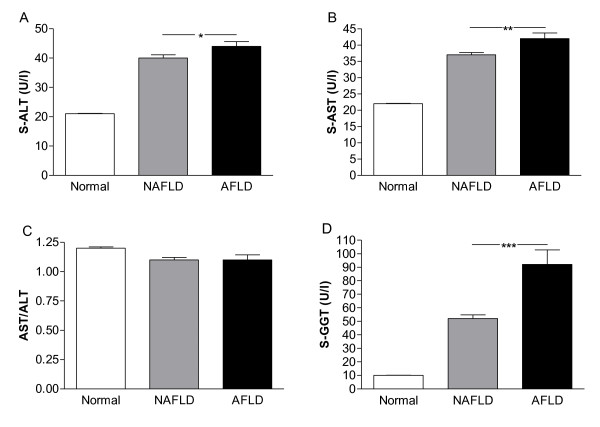
(A) S-ALT concentrations, (B) S-AST concentrations, (C) AST/ALT-ratio, and (D) S-γGT concentrations in subjects with normal LFTs [subjects with low (n = 1691) or high (n = 308) alcohol consumption, Additional file 1], NAFLD, and AFLD. For differences between normal LFTs vs. NAFLD or AFLD, please see Additional file 1. *p < 0.05, *p < 0.01, ***p < 0.001. The error-bars are standard error of the mean.